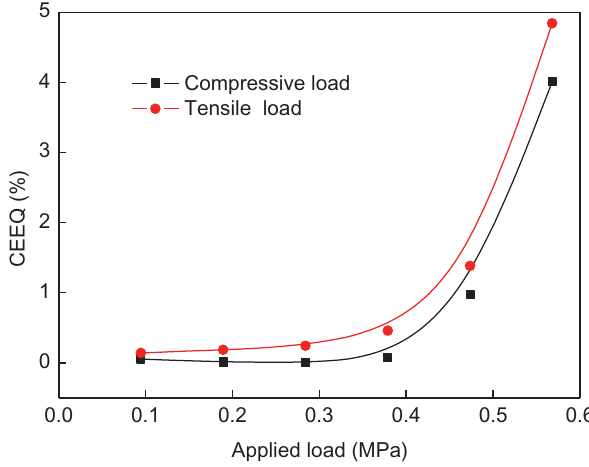
Figure 12: Effect of the applied load on the local maximum CEEQ at compressive and tensile loads.